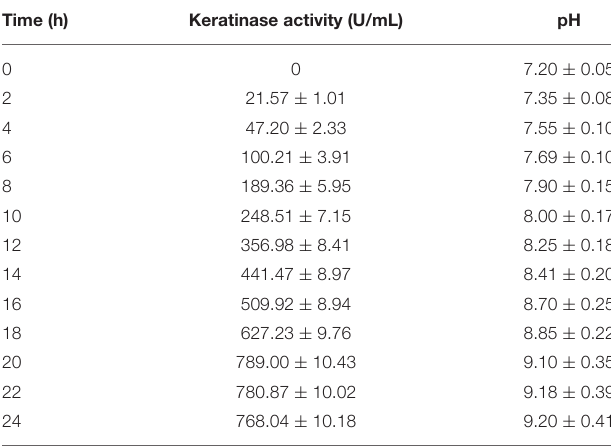
TABLE 2 | Chicken feather degradation in 5L fermenter depicting change in keratinase activity and pH in reaction system with due course of time. Time (h)